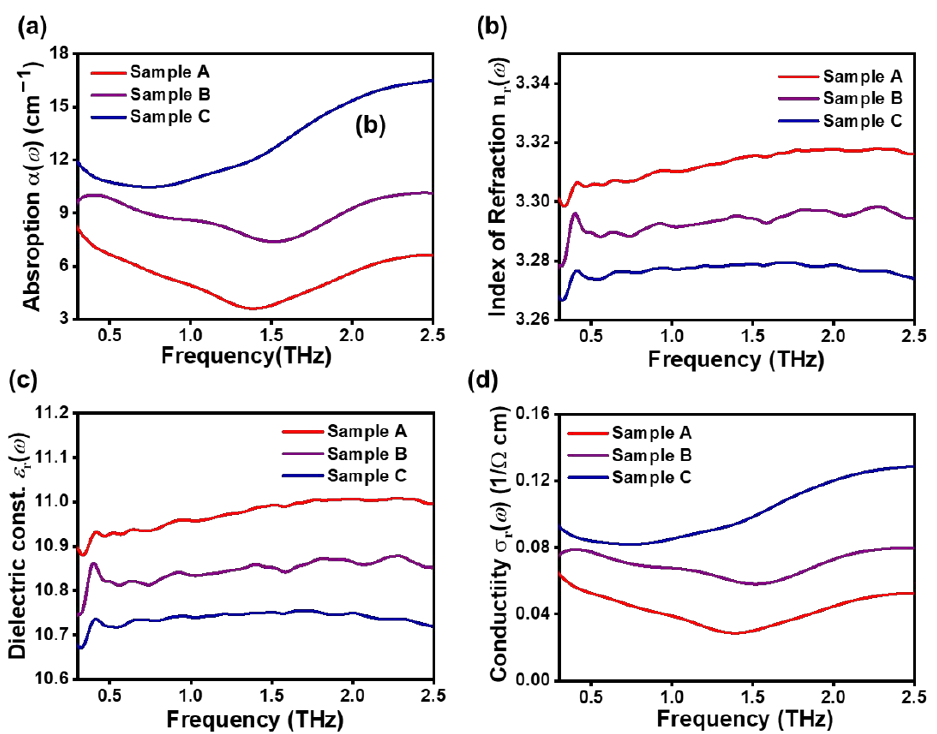
Figure 5. ( a ) Absorption α ( ω ); ( b ) real part of refractive index n r ( w ); ( c ) real dielectric constant ε r ( ω ) ; and ( d ) real conductivity σ r ( w ) of samples (A, B, and